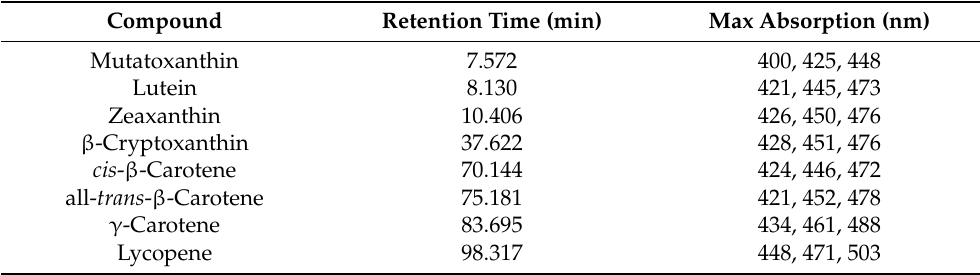
Table 5. Carotenoids used as standards in RP-HPLC analysis and their retention